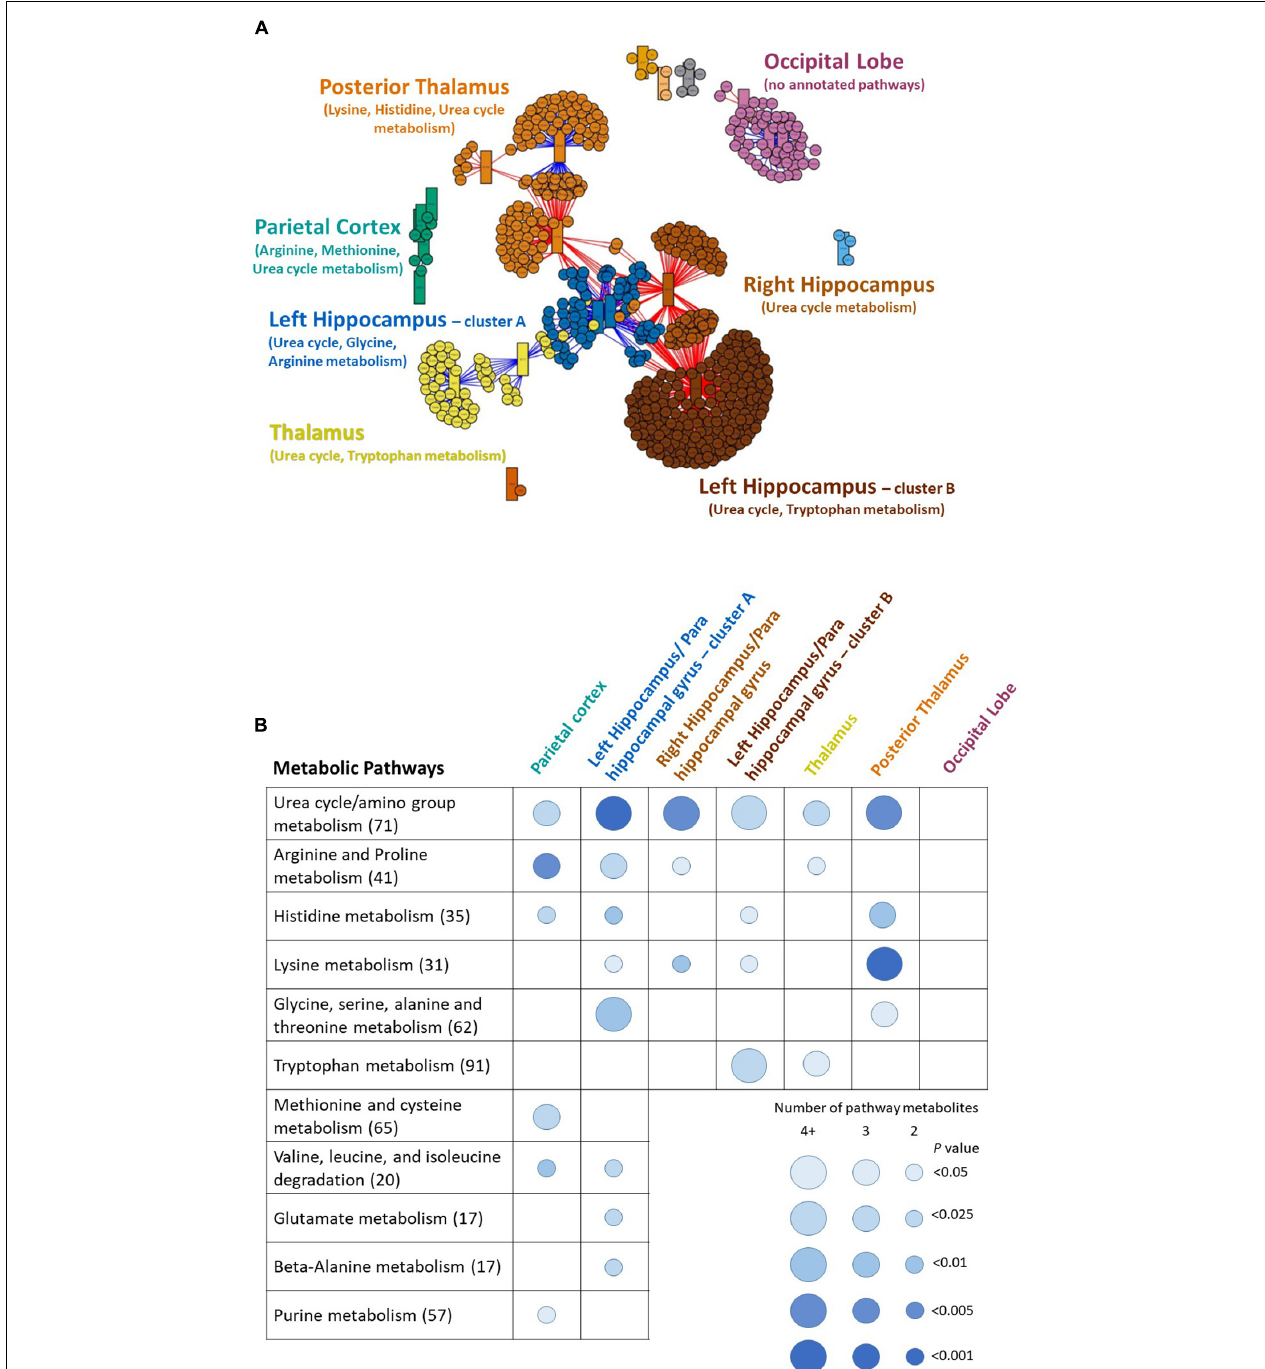
FIGURE 1 | (A) Multiomics clustering network of MRI-derived gray matter brain imaging voxels and CSF metabolites. The network algorithm (xMWAS) identified twelve distinct imaging-metabolite clusters. Each cluster is indicated by a different color. The seven clusters that correspond to contiguous regions of the brain are labeled. The circles are MRI brain imaging voxels and the rectangles are cerebrospinal fluid metabolites. Blue lines indicate positive correlation with controls, red lines indicate negative correlation. This is a modified figure limiting the number of voxels, metabolites, and connections to visualize the clusters and their relationships. The unaltered figure is in Supplementary Figure 5 . (B) The associated metabolic pathways from the seven annotated imaging-metabolite clusters identified by the multiomics network. Metabolic pathway enrichment analysis (Mummichog) described the dysregulated metabolic pathways specific to each region of the brain. The size and color of the circles indicate the number of significant overlapping metabolic features in the pathway and the Fisher’s exact P -value of each pathway. The number next to the metabolic pathway is the number of reference metabolites in each pathway. The metabolites that correlated with the occipital lobe were sparse and did not collectively map to a specific known